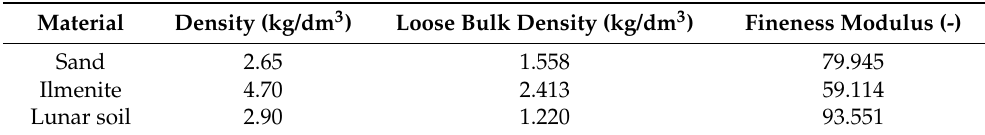
Table 1. Properties of standardized sand, ilmenite, and lunar soil